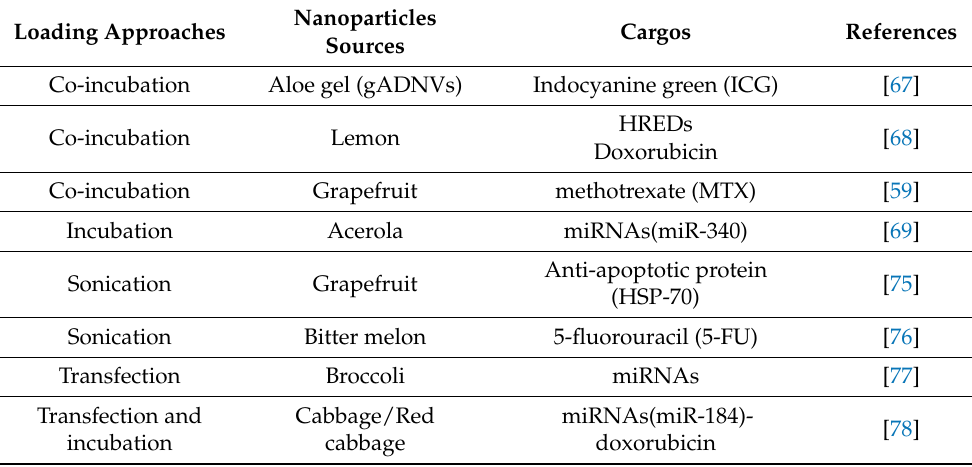
Table 1. Summary of the strategies for the exogenous loading of